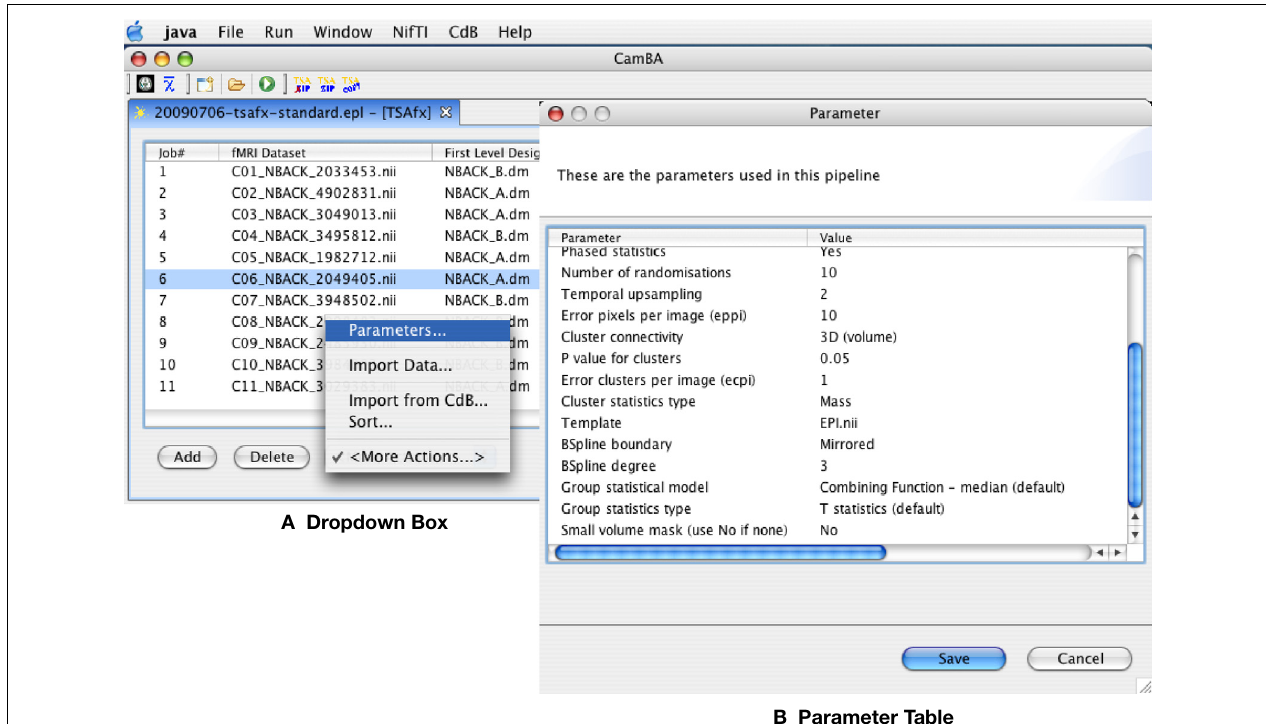
FIGURE 2 | Steps in operation by consumers to modify parameters for the workfl ow. See text for